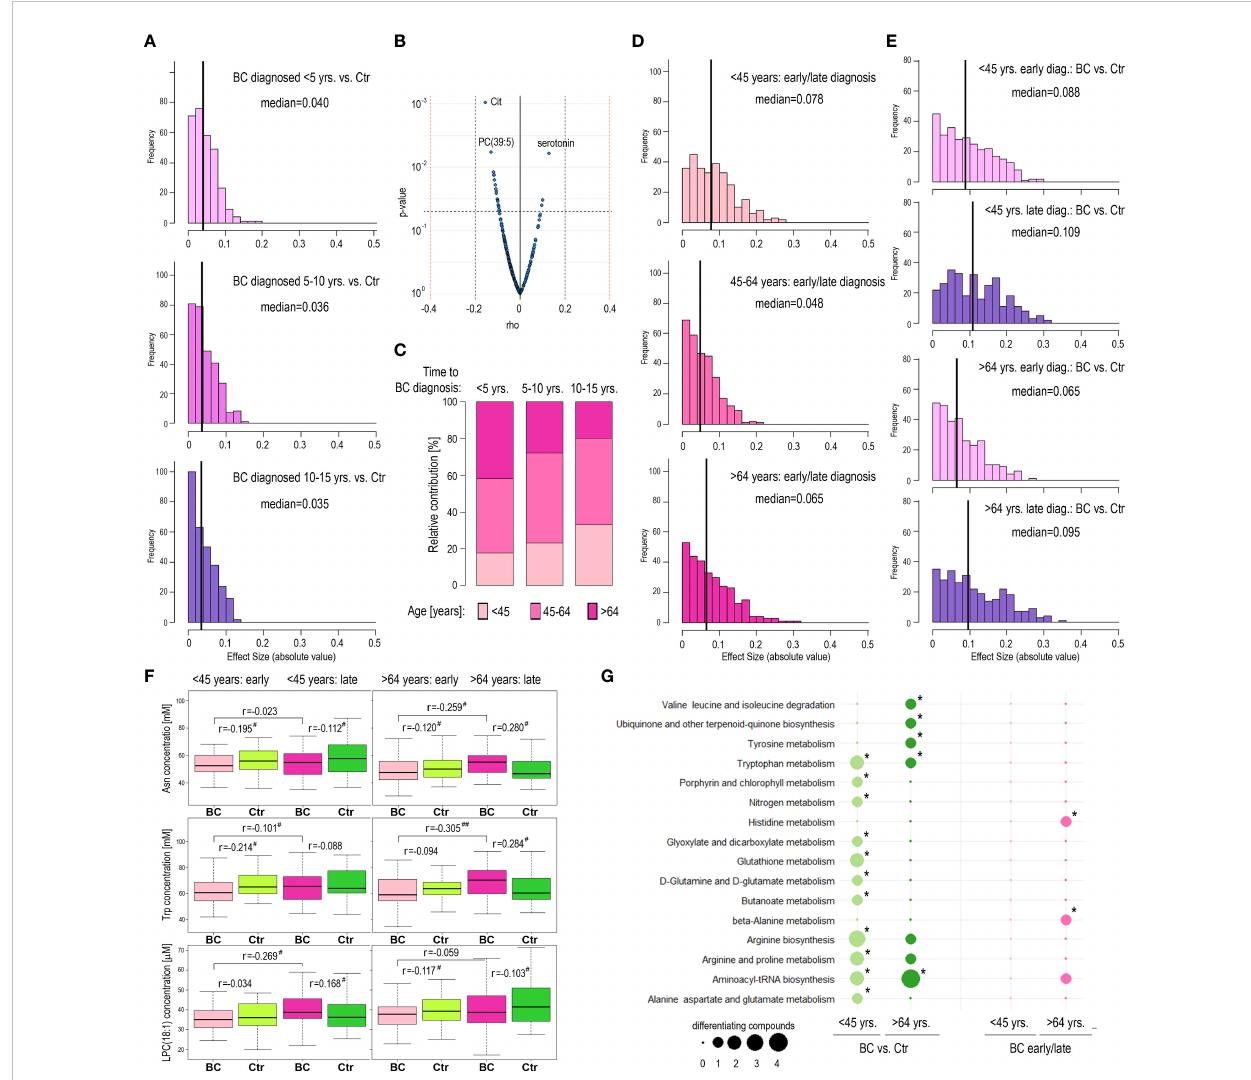
FIGURE 3 Metabolome pro fi les in pre-diagnostic serum samples of HUNT2 study participants with earlier and later diagnoses of breast cancer. (A) – Distribution of metabolites that showed the increased magnitude of differences between BC and corresponding controls in three subgroups of participants with different times to cancer diagnoses during follow-up, 5 years (early); 5-10 years; and 10-15 years (late). (B) – The signi fi cance of the correlation between serum metabolite concentrations in pre-diagnostic samples and time to cancer diagnosis. (C) – Contribution of women at different ages during inclusion (<45-year-old; 45-64-year-old; and >64-year-old) in subgroups of BC cases diagnosed during 5 years (early); 5-10 years; and 10-15 years (late) follow-up. (D) – Distribution of metabolites that showed the increased magnitude of differences between participants with early (<5 years) and late (10-15 years) diagnoses of breast cancer in three age-de fi ned subgroups of participants (<45-year-old; 45-64-year-old; and >64-year-old). (E) – Distribution of metabolites that showed the increased magnitude of differences between BC and corresponding controls in four subgroups of participants, younger/early diagnosis; younger/late diagnosis; older/early diagnosis; and older/late diagnosis. (F) – Differences in concentration of selected metabolites (Asn; Trp; and LPC(18,1)) between BC cases and controls in four subgroups of participants, younger/early diagnosis; younger/late diagnosis; older/early diagnosis; and older/late diagnosis; differences in pre-diagnostic samples of participants with an earlier and later cancer diagnosis are also marked (# - small effect size; ## - medium effect size). (G) – Metabolic pathways associated with compounds whose levels were different between BC cases and controls in subgroups of younger and older participants (<45-year-old and >64-year-old; respectively) as well as between younger and older participants with an early and late cancer diagnosis (<5 years and 10-15 years follow-up; respectively); signi fi cantly overrepresented pathways are marked with asterisks (size of a dot corresponding to the number of differentiating compounds associated with a given